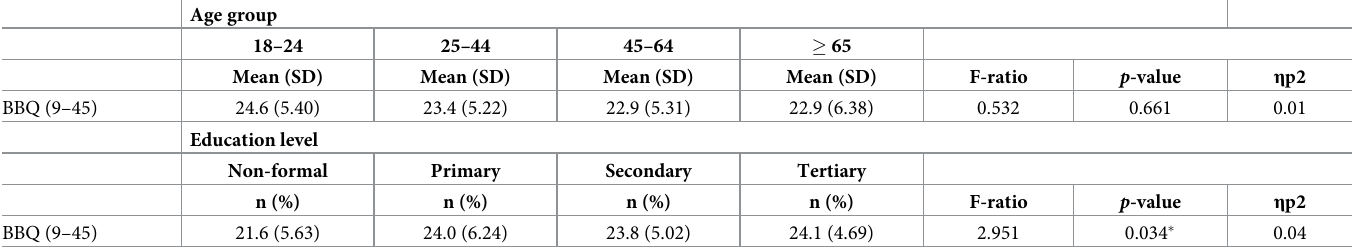
Table 4. Known-groups validity of the Hausa Back Beliefs Questionnaire.